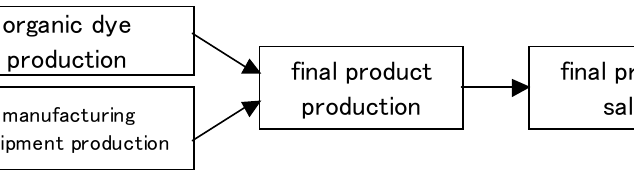
Figure 6. Flowchart of important activities of OSMW industry